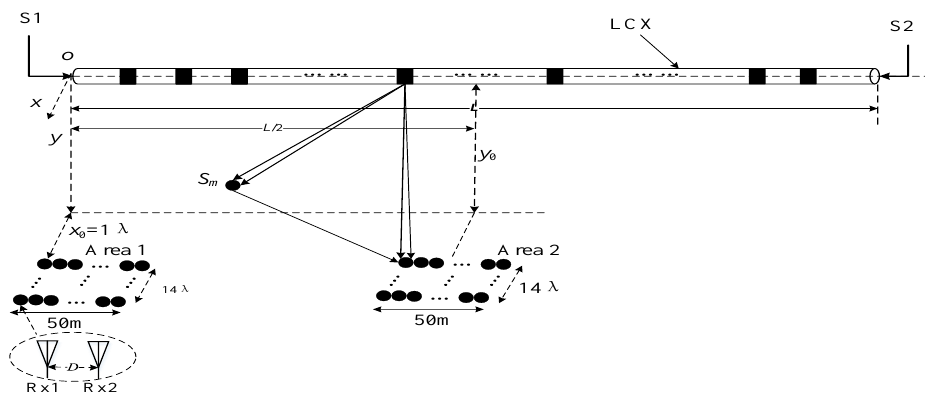
Figure 8. MIMO system with single long double-port fed LCX in tunnel. Table 7. Parameters of the LCX MIMO System.